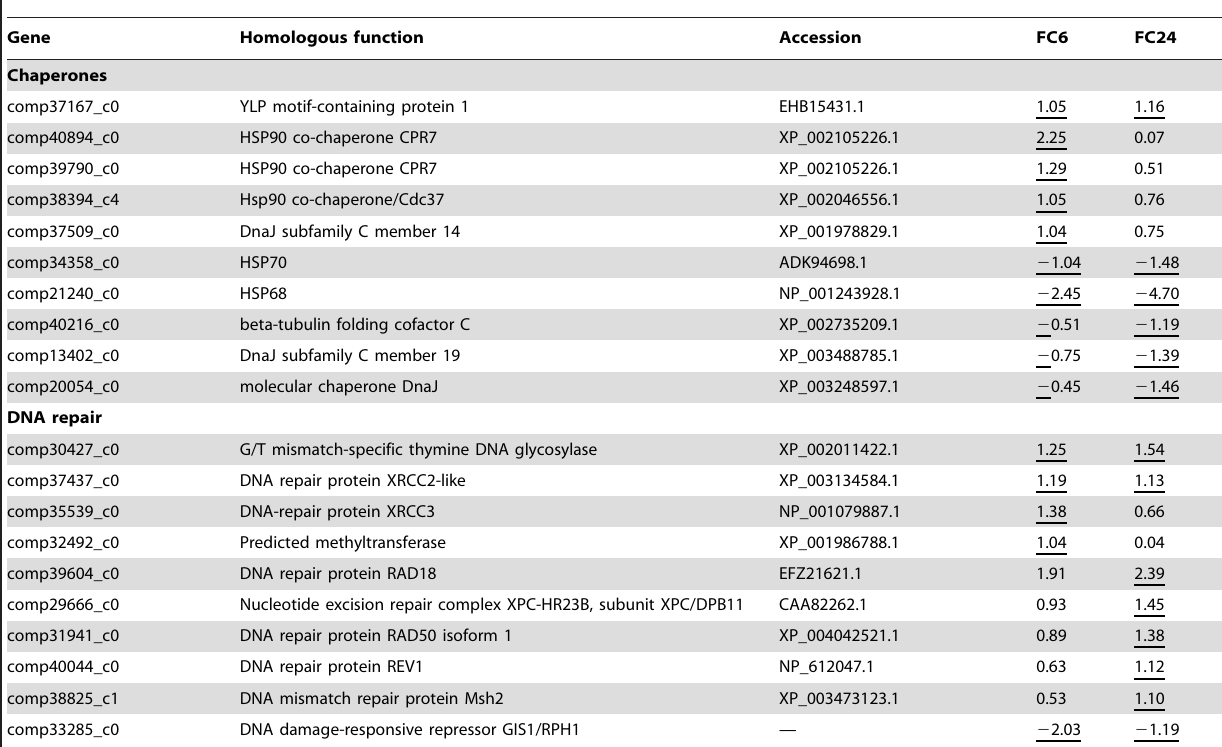
Table 4. Genes involved in protein folding and DNA repair.